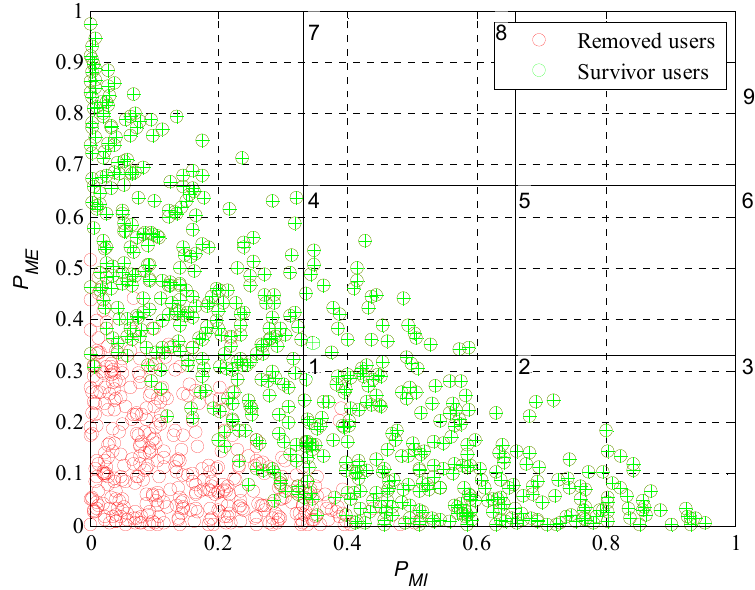
Figure 13. Graphical representation of user motivation levels on a Cartesian plane divided into subgroups.